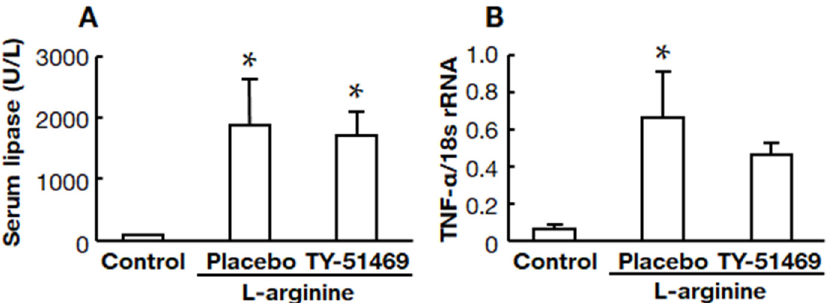
Figure 3. Effects of TY-51469 on serum lipase and pancreatic TNF- α mRNA levels. Serum lipase ( A ) and pancreatic TNF- α mRNA levels ( B ) in control, placebo-, and TY-51469-treated groups 8 h after the injection of L-arginine (control group: n = 6, placebo-treated group: n = 8, TY-51469-treated group: n = 8). Values represent means ± SEM. * p < 0.05 vs. control group.